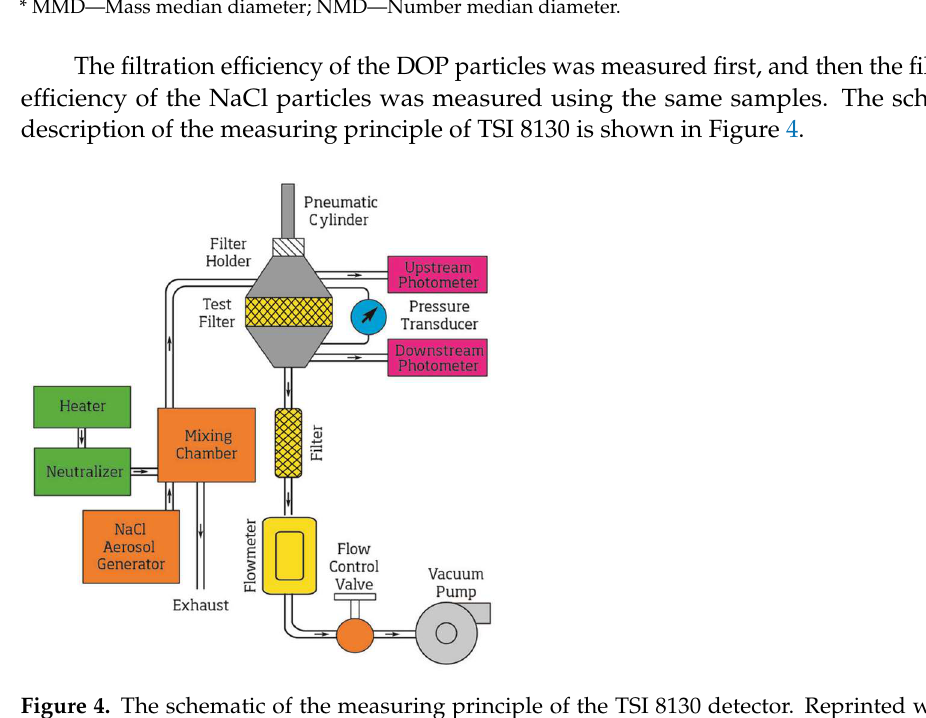
Figure 4. The schematic of the measuring principle of the TSI 8130 detector. Reprinted with per- mission from Ref. [46]. 2021, TSI Incorporated.